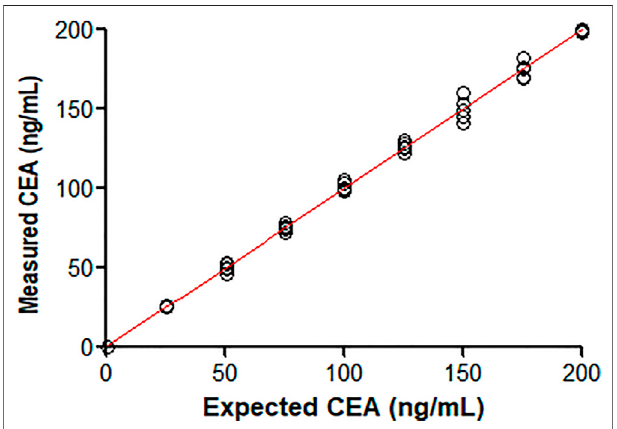
FIGURE 2 | Comparison of measured CEA values against known concentrations of nine different CEA-spiked samples.